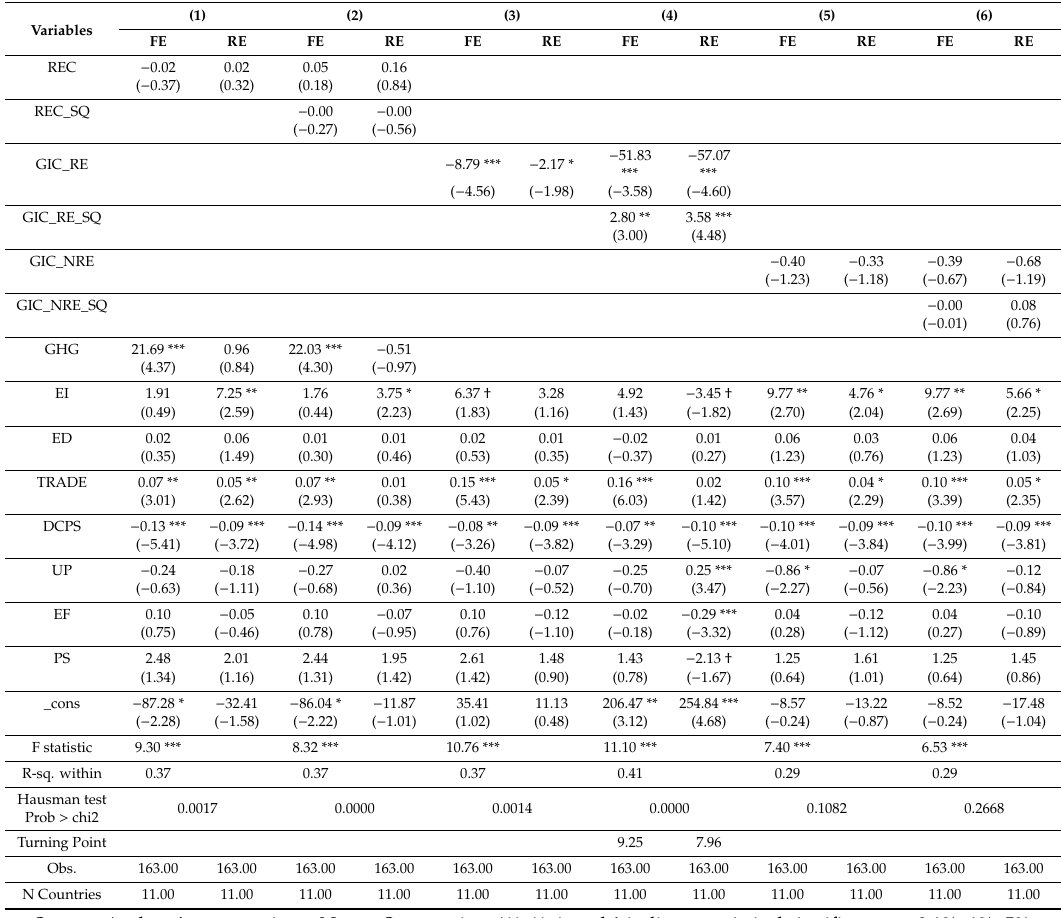
Table 5. Panel data regression models towards the influence of renewable and non-renewable energy consumption on economic